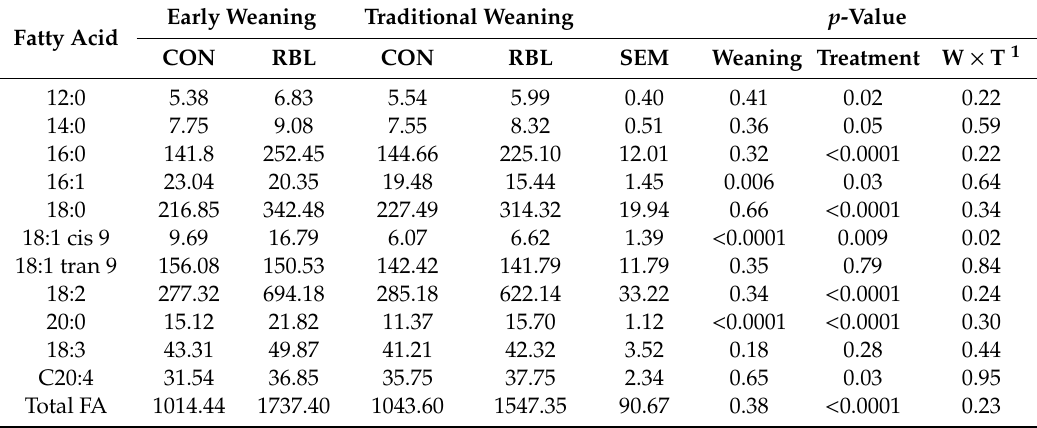
Table 4. Specific and total serum fatty acids (mg / mL) on d 45 of steers that were early weaned at 150 d of age (n = 24) or traditionally weaned at 210 d of age (n = 24) and then supplemented with a rumen by-pass lipid ration (RBL) or an isocaloric, isonitrogenous control diet (CON). Early Weaning